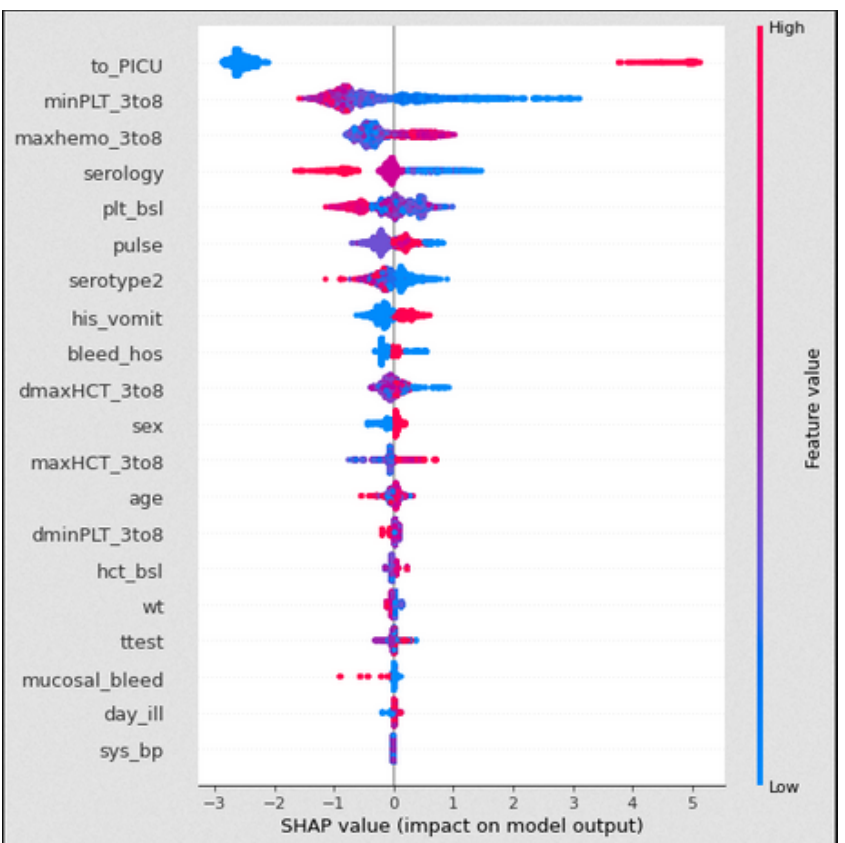
Figure 2. Summary plot of different features of the datasets using SHAP values on XGBoost classifier